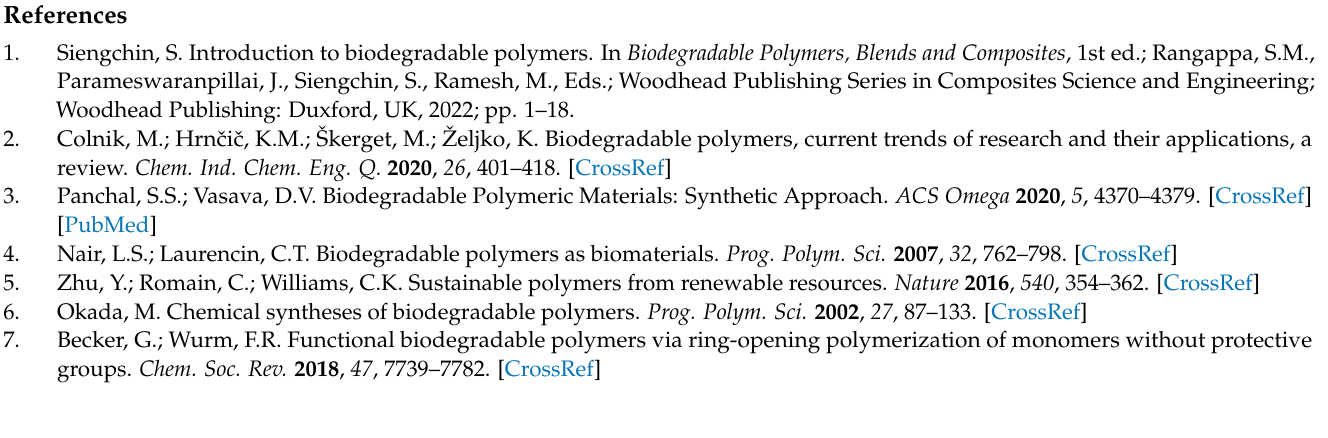
BNC; Figure S2: AFM imagesI of 4 h UV-irradiated H-2 sample; Figure S3: AFM images of 4 h UV-irradiated H-4; Figure S4: AFM images of 4 h UV-irradiated I-2; Figure S5: AFM images of 4 h UV-irradiated I-4; Figure S6: AFM images of 4 h UV-irradiated S-2; Figure S7: AFM images of 4 h UV-irradiated